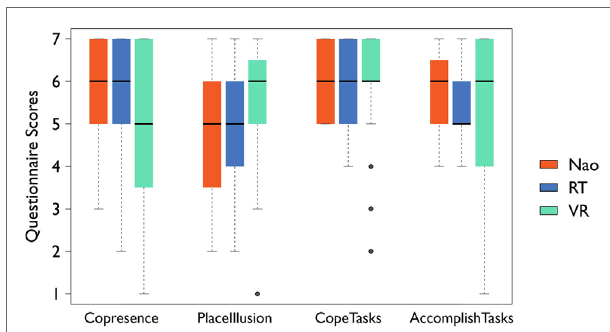
FigUre 6 | responses to questions on place illusion and task performance per destination, as provided in Table 2 . Responses were